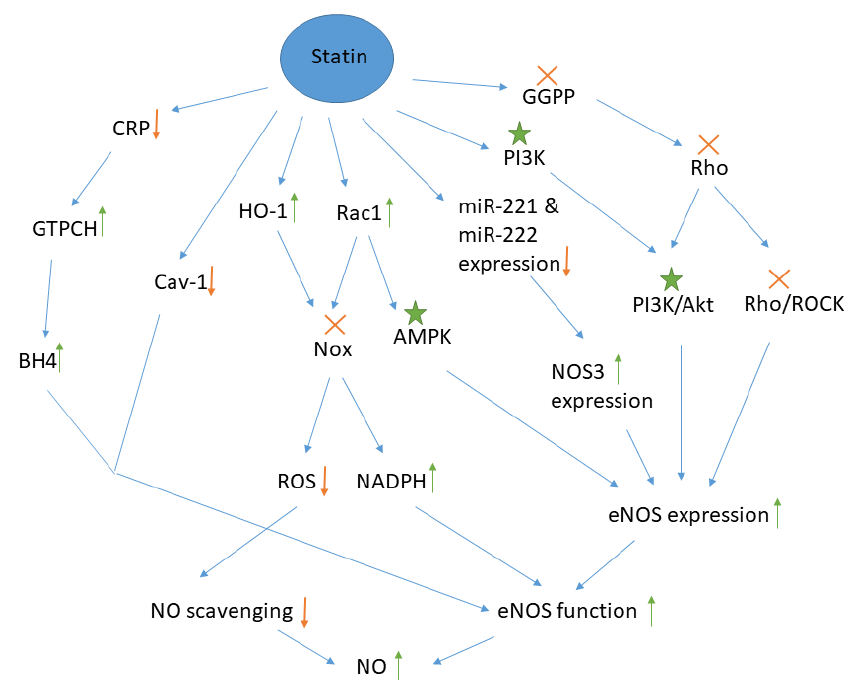
Figure 1. Molecules and pathways involved in the effect of statins on NO production by endothelial cells. : Molecule has become unavailable or inactivate or the signaling pathway is suppressed, : Increase or decrease in the amount, : Molecule is activated. GGPP: geranylgeranyl pyrophosphate, ROCK: Rho-associated protein kinase, PI3k: Phosphoinositide 3-kinase, Akt: Protein kinase B, AMPK: AMP-activated protein kinase, miR: micro RNA, HO-1: Heme oxygenase 1, BH4: tetrahydrobiopterin, Nox: NADPH oxidase, Cav-1: caveolin-1, GTPCH: guanosine-5-triphosphate cyclohydrolase, CRP: C reactive protein, NO: nitric oxide, eNOS: endothelial NO synthase, ROS: reactive oxygen species. It is noteworthy that Rac1 is actually a downstream signal for GGPP and the statin-mediated inactivation of GGPP reduces Rac1 level but as statins exert a direct inductive e ff ect on Rac1, the up-regulation of Rac1 and its downstream signaling are shown separately